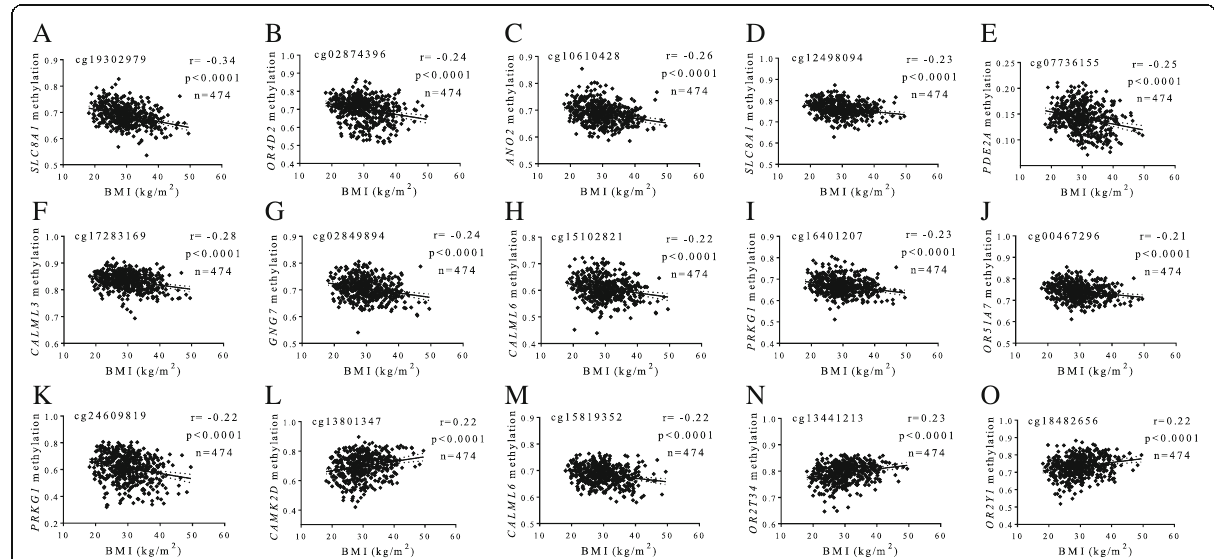
Fig. 1. Associations between methylation levels (beta values) at olfactory pathway genes and BMI values. a cg19302979, SLC8A1 ( b ) cg02874396, OR4D2 ( c ) cg10610428, ANO2 ( d ) cg12498094, SLC8A1 ( e ) cg07736155, PDE2A ( f ) cg17283169, CALML3 ( g ) cg02849894, GNG7 ( h ) cg15102821, CALML6 ( i ) cg16401207, PRKG1 ( j ) cg00467296, OR51A7 ( k ) cg24609819, PRKG1 ( l ) cg13801347, CAMK2D ( m ) cg15819352, CALML6 ( n ) cg13441213, and OR2T34 ( o ) cg18482656, OR2Y1